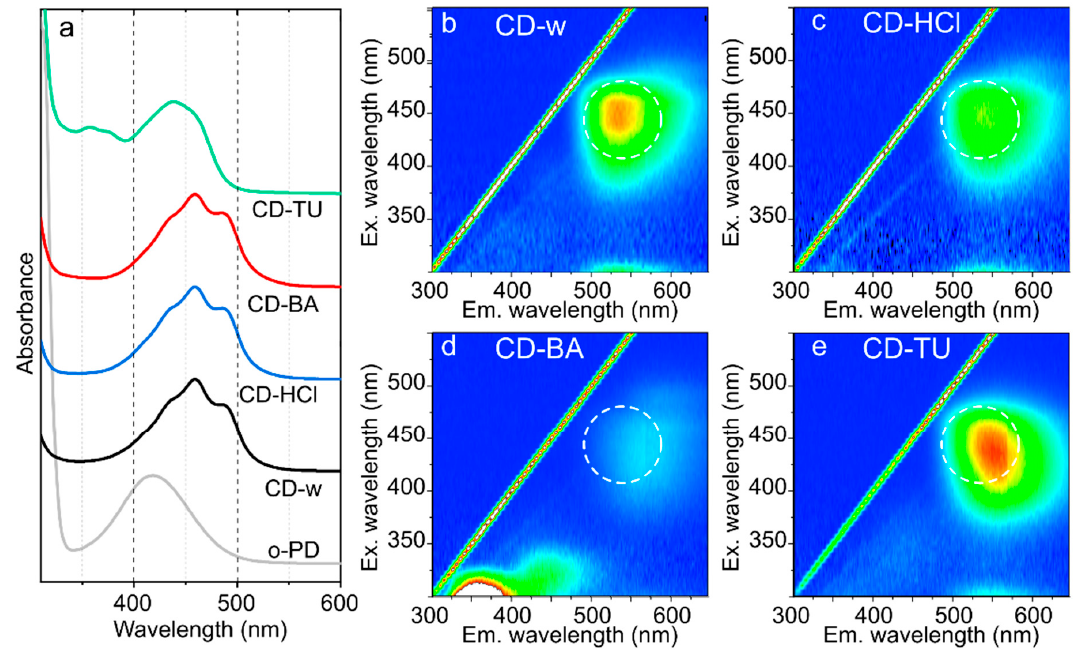
Figure 2. ( a ) Absorption spectra of o-PD (grey) and CDs: CD-w (black), CD-HCl (blue), CD-BA (red), CD-TU (green). ( b – e ) PL excitation-emission maps of CD-w ( b ), CD-HCl ( c ), CD-BA ( d ), CD-TU ( e ). For comparison, the PL band of CD-w is shown as a dashed circle.